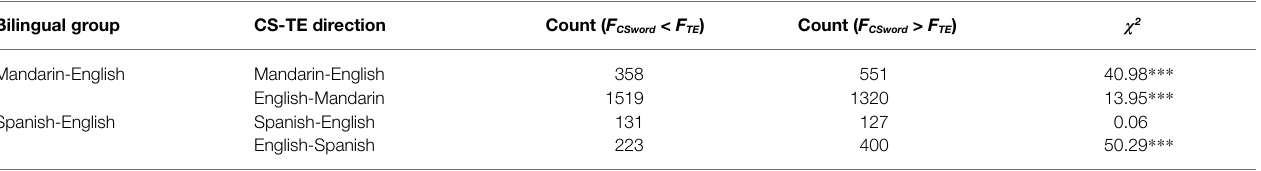
TABLE 5 | Statistical results of the sign tests for the frequency (per million) of words. Bilingual group CS-TE direction Count ( F CSword < F TE ) Count ( F CSword > F TE ) χ